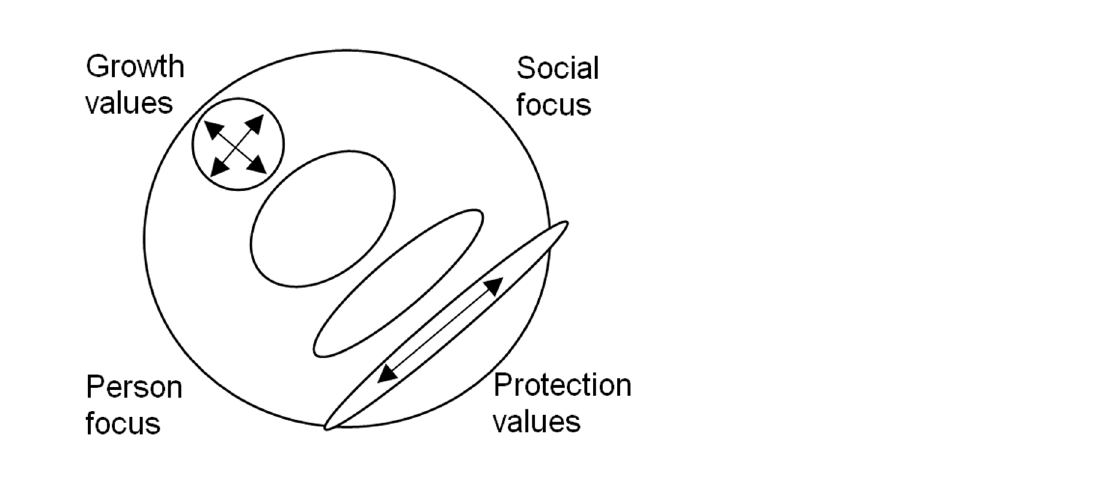
Figure 5. Schematic representation of the dimensionality of the value structure within a sample as a function of its mean location in the value